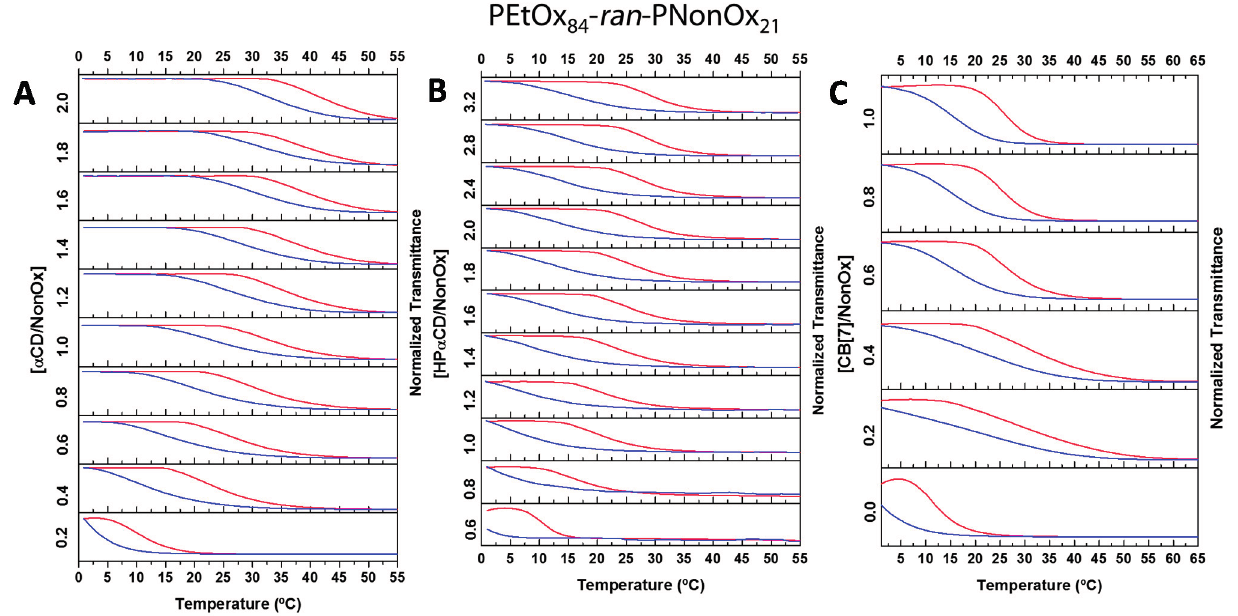
Figure 4. Turbidimetry studies of P[(EtOx) 84 - ran -(NonOx) 21 ] with increasing cavitand/NonOx molar ratios. 5 mg·mL − 1 solutions of copolymer were titrated with α CD ( A ) and HP α CD ( B ), whereas a 2 mg·mL − 1 solution of copolymer was titrated with CB7 ( C ). The heating and cooling ramps are represented by the top (red) and bottom (blue) curves, respectively. Rate: 1 K·min − 1 , λ = 700